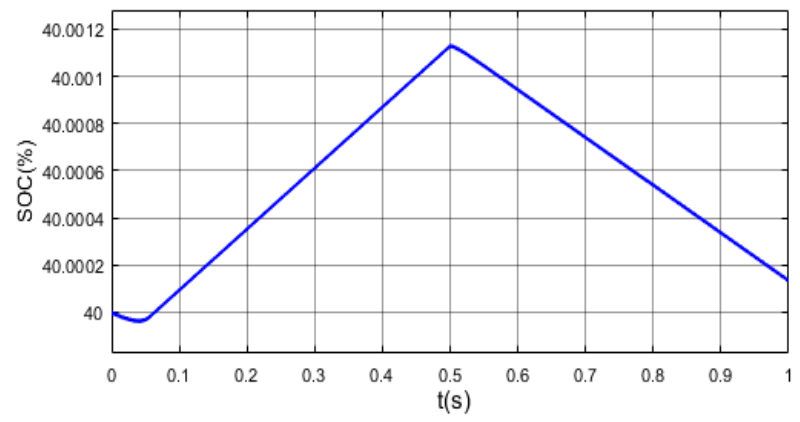
Figure 12. Curve of battery.